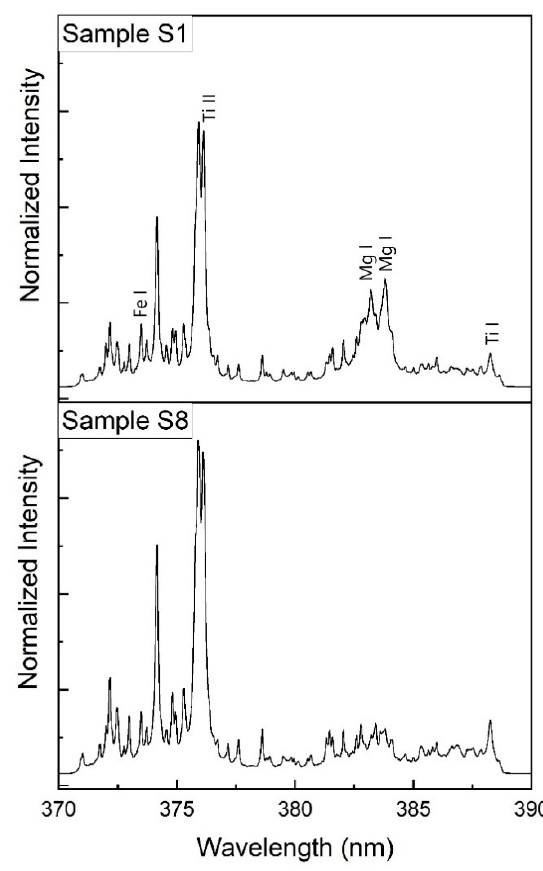
Figure 3. LIBS spectrum of Samples S1 (high Mg content) and S8 (low Mg content) slag samples.